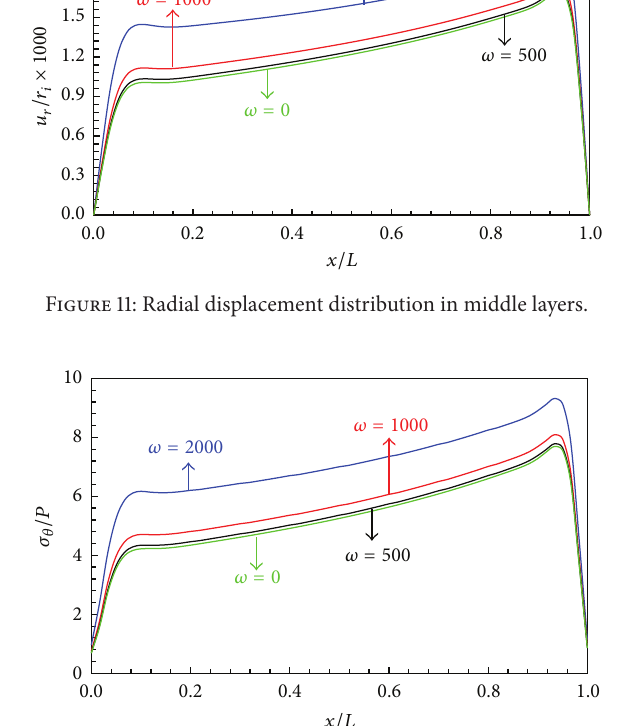
Figure 12: Circumferential stress distribution in middle layers.